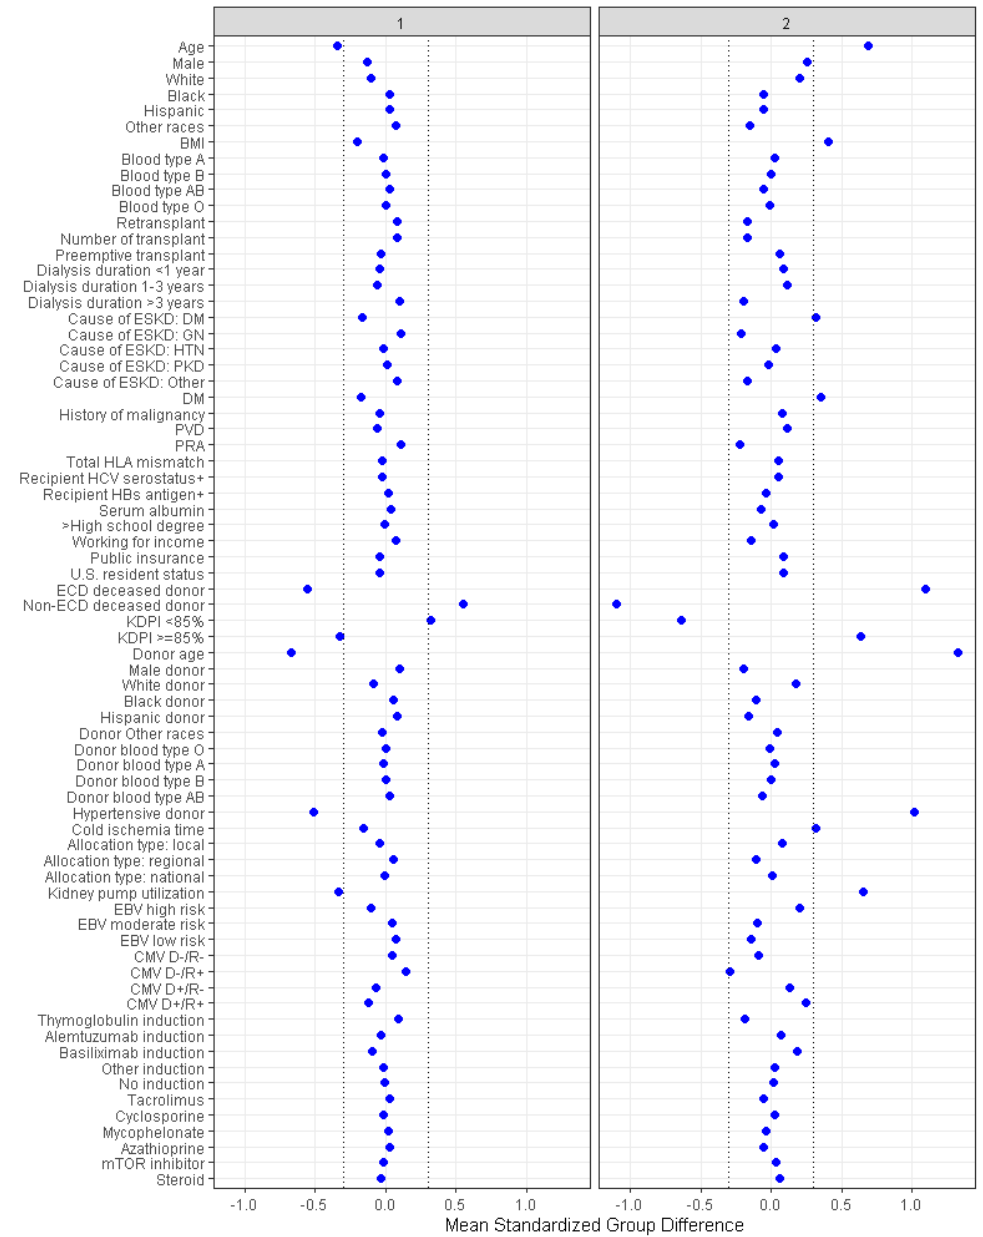
Figure 3. The standardized differences across two DKT clusters for each of baseline parameters.